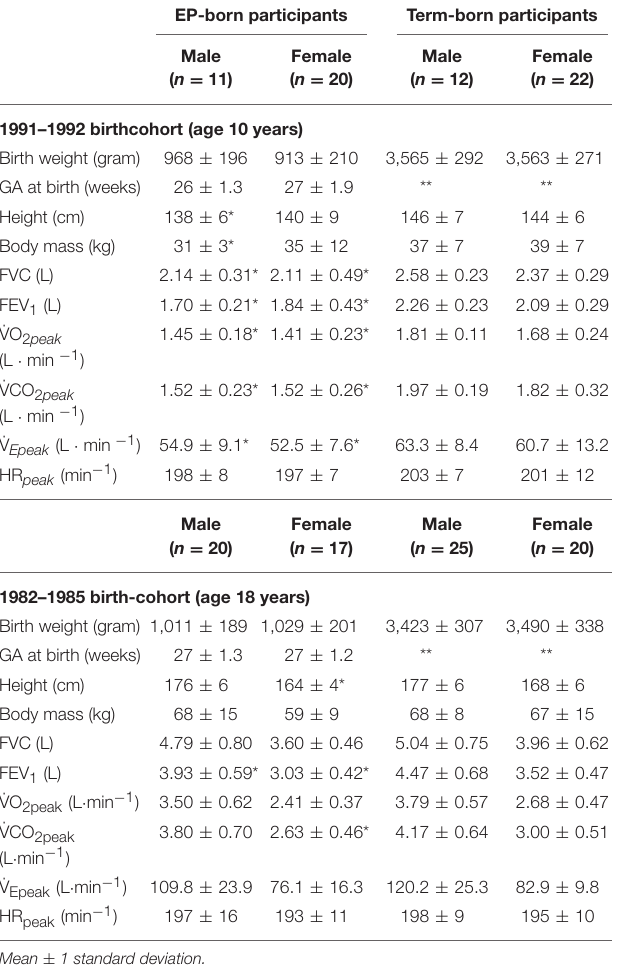
TABLE 1 | Participant characteristics and peak responses to progressively incremental exercise test on treadmill.